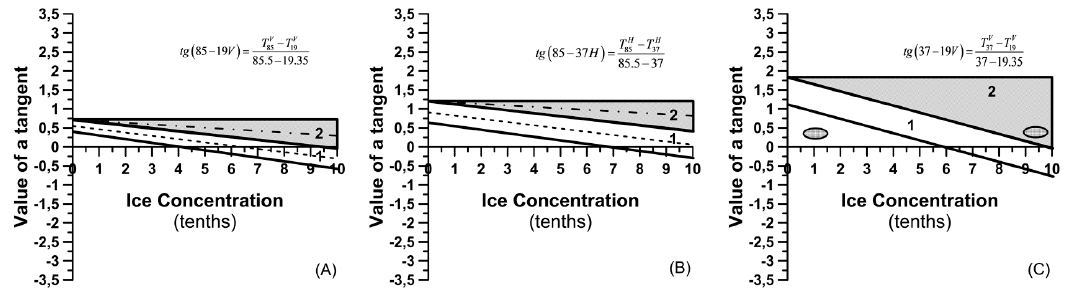
Figure 1. Dependencies of tangents tg (85–19 V) ( A ), tg (85–37 H) ( B ), and tg (37–19 V) ( C ) on sea ice concentration (SIC). Open region (1) between the two straight lines corresponds to ice cover with and without snow on top, shaded triangle (2) to ice cover with snow-water mixture (SWM). Dash-dotted and dashed lines denote the medians of the regions.